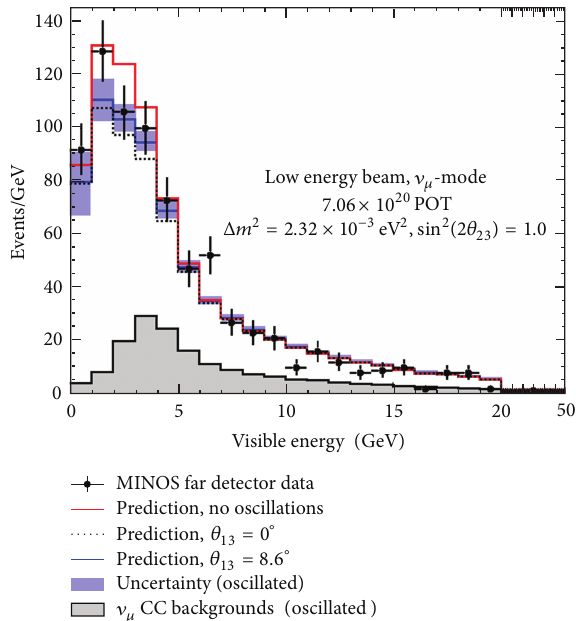
Figure 22: Visible energy spectrum of MINOS Far detector neutral- current event candidates [45]. The data are shown by the black points. The prediction obtained from the Near detector data is shown for three cases: no oscillations (red); oscillations with atmospheric parameters and 𝜃 13 = 8.6 ∘ (dashed black); oscillations with atmospheric parameters and 𝜃 13 = 0 ∘ (dashed black). The contamination of the NC spectrum from 𝜈 𝜇 CC events is shown by the gray